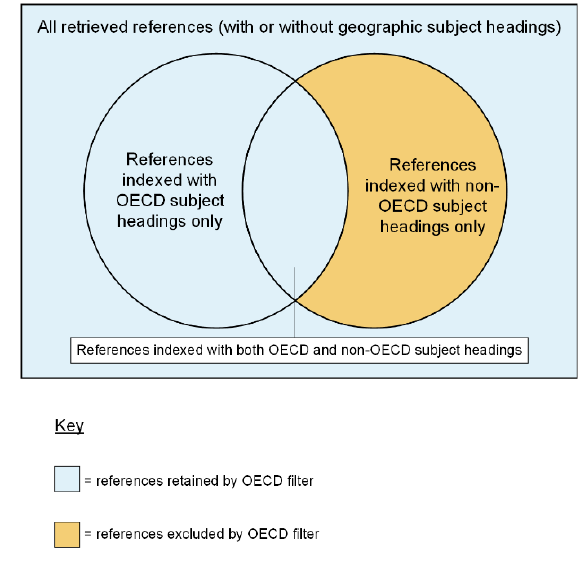
the OECD countries’ filters (not to